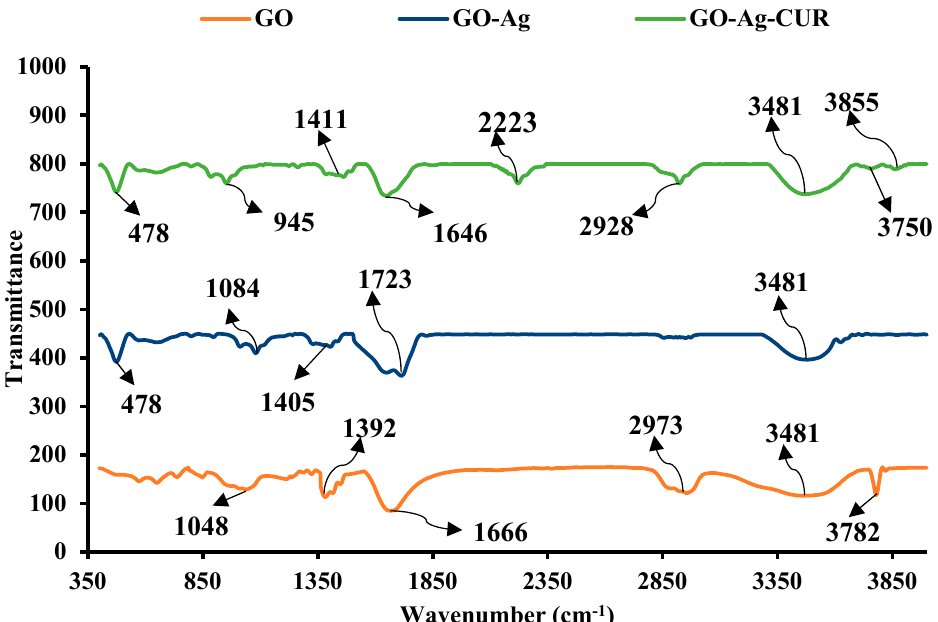
Figure 1. The FTIR spectra of GO, GO-Ag, GO-Ag-CUR.